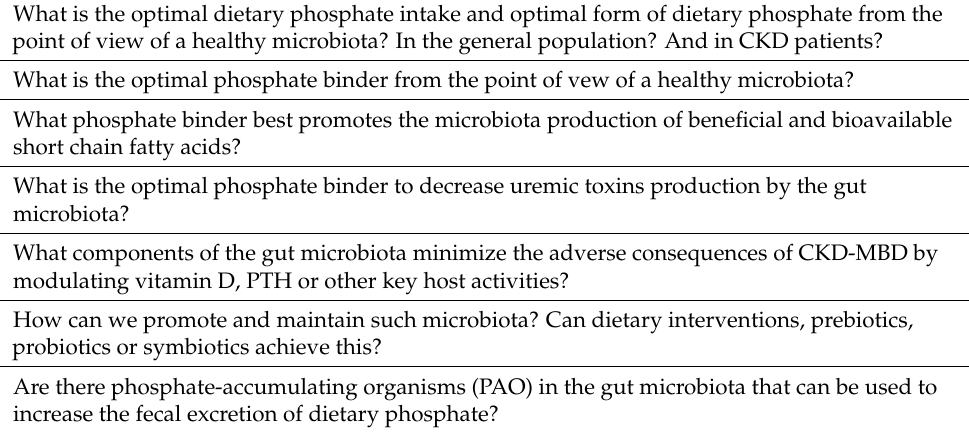
Table 3. Key research questions on phosphate and microbiota. What is the optimal dietary phosphate intake and optimal form of dietary phosphate from the point of view of a healthy microbiota? In the general population? And in CKD patients? What is the optimal phosphate binder from the point of vew of a healthy microbiota? What phosphate binder best promotes the microbiota production of beneficial and bioavailable short chain fatty acids? What is the optimal phosphate binder to decrease uremic toxins production by the gut microbiota? What components of the gut microbiota minimize the adverse consequences of CKD-MBD by modulating vitamin D, PTH or other key host activities? How can we promote and maintain such microbiota? Can dietary interventions, prebiotics, probiotics or symbiotics achieve